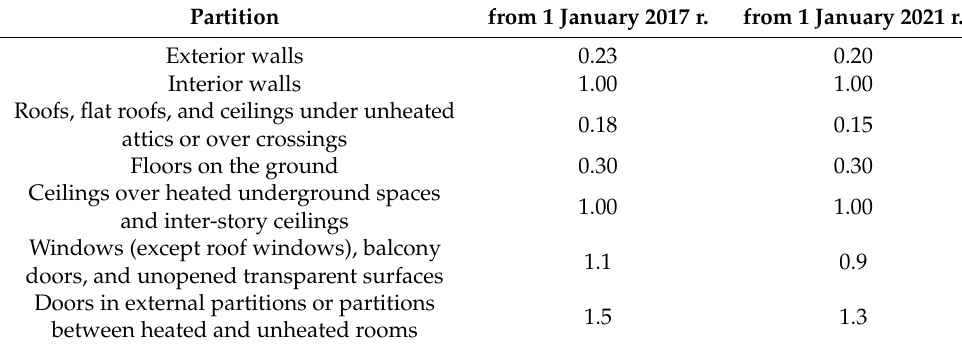
Table 4. Maximum values of the permeation coefficient warm U c,max